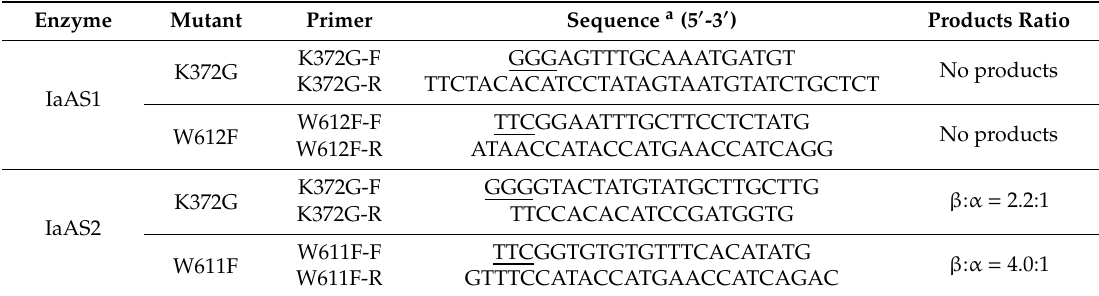
Table 3. Primers used for IaAS1 and IaAS2 mutation.